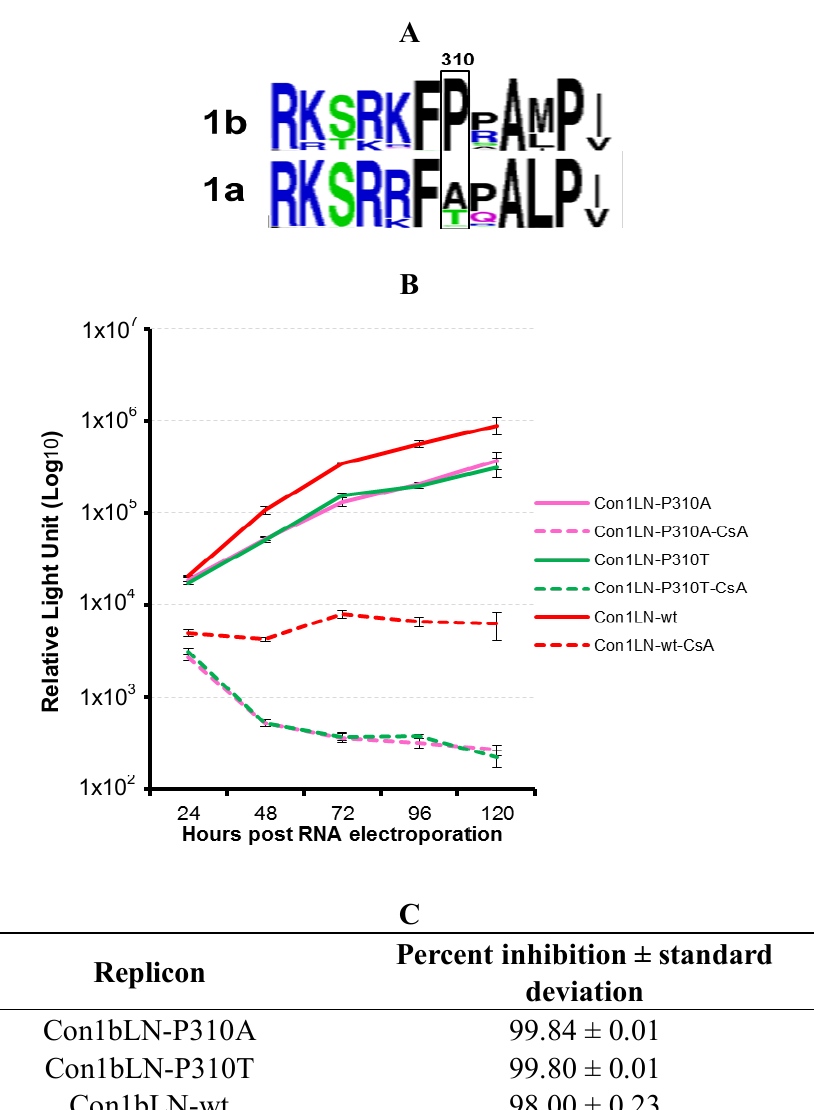
Figure 4. Mutational analysis of Con1bLN-wt replicon at position 310 and analysis of CsA susceptibility. ( A ) Logo analysis of the C2 region of 358 isolates from genotype 1b and 224 from genotype 1a of HCV NS5A. The boxed proline residue at position 310 appears to be highly conserved among most HCV 1b viruses. Sequences derived from genotype 1b and 1a are marked. ( B ) The CsA susceptibility of Con1bLN-P310A, Con1bLN-P310T was compared to Con1bLN-wt replicons. ( C ) The percent inhibition of respective replicons in (B) were calculated and